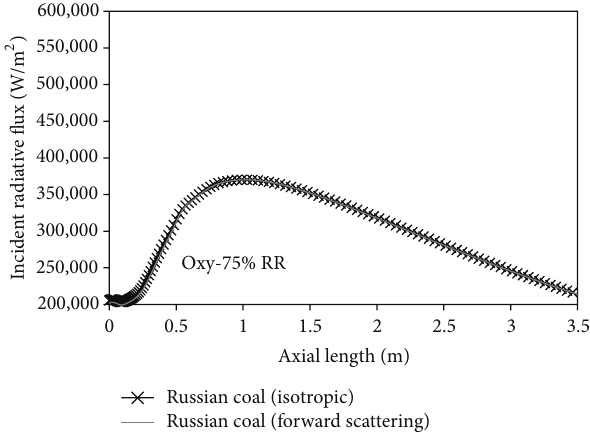
Figure 11: Sensitivity to scattering phase function during the combustion of Russian coal during oxy-75%